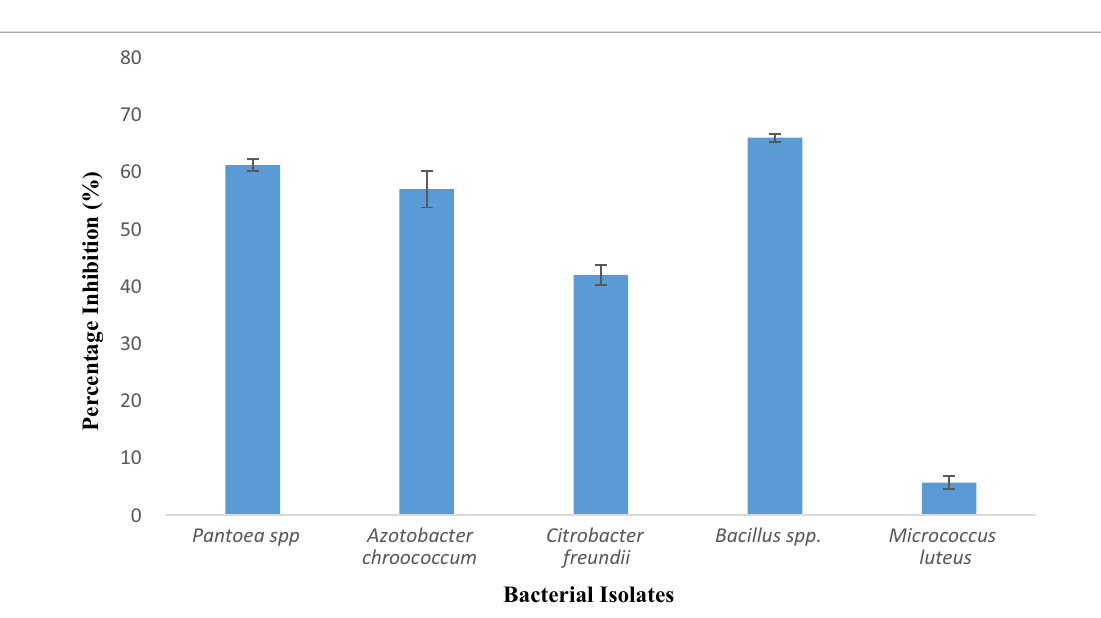
Fig. 3 Antagonistic activities of termite mound soil bacteria against R.